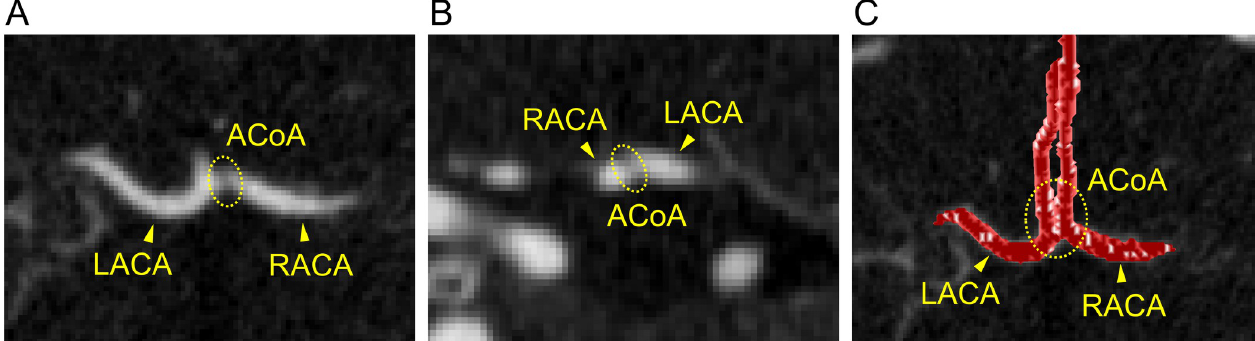
Fig 3. Computed tomography (CT) images of Patient 2. (A) Transverse plane, (B) frontal plane, and (C) volume-rendered image. The ACoA was not recognized on CT images of this patient, suggesting hypoplasia of the ACoA. ACoA, anterior communicating artery; LACA, left anterior cerebral artery; RACA, right anterior cerebral artery.